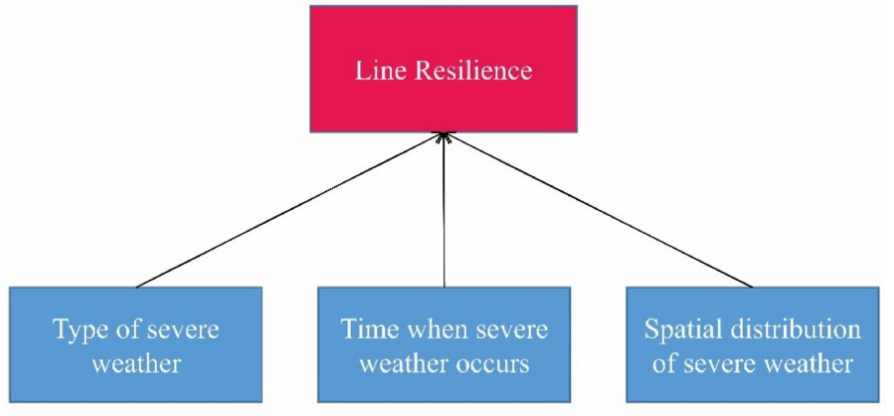
Figure 5. Schematic of the Bayesian network structure in the resilience